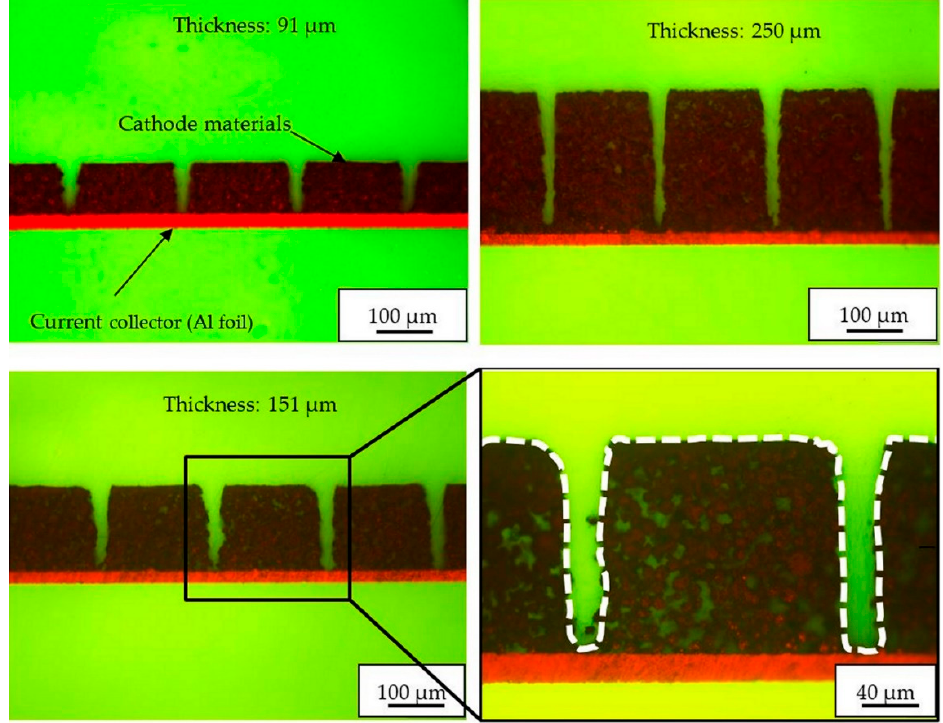
Figure 2. Cross-sectional view of Li(Ni 0.6 Mn 0.2 Co 0.2 )O 2 (NMC 622) cathodes with different film thicknesses (pitch distance: 200 µm).